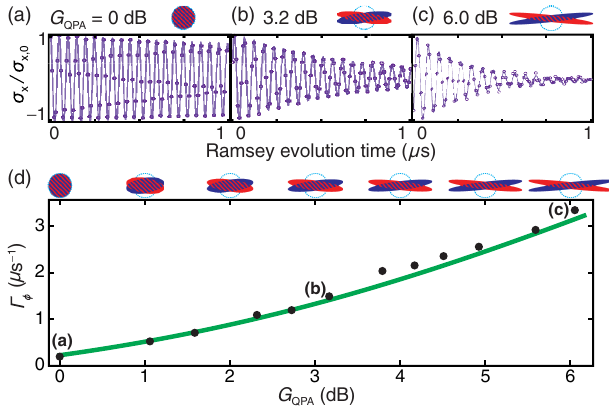
FIG. 2. (a) – (c) Ramsey experiments demonstrating the parasitic effect of on-chip gain G on qubit dephasing. No measurement QPA tone is applied during the Ramsey free evolution. Increasing G increases the QPA output-field squeezing, thus decreasing QPA the phase-space overlap of the output fields conditioned on the ground or excited qubit states as approximately represented by the red and blue ellipses. The decreased overlap implies faster parasitic dephasing. (d) The observed dependence of Γ ϕ on G QPA (black dots) is in good agreement with Eq. (2) (green curve); the thickness of the curve is the standard deviation of the background dephasing rate 1 =T (cid:3) 2